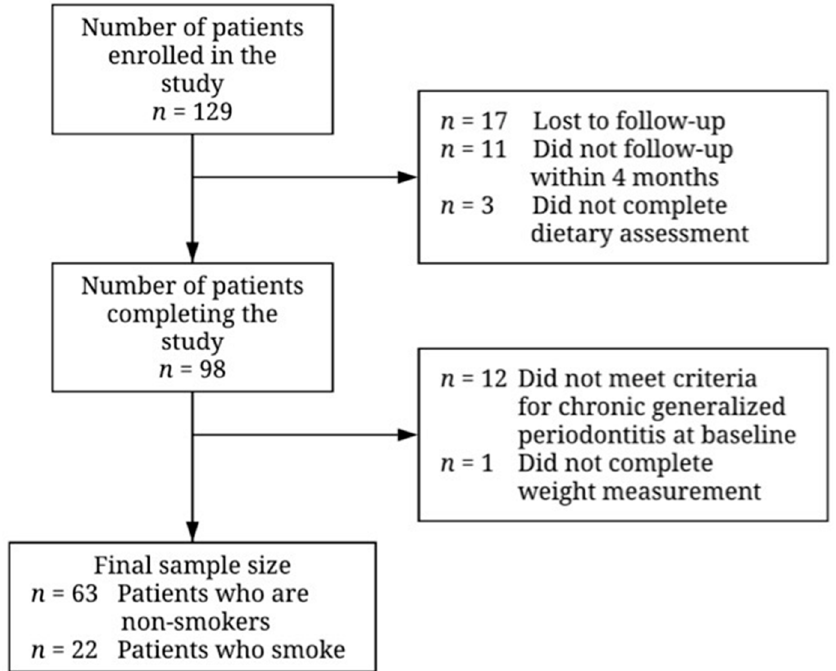
Figure 1. Flowchart illustrating recruitment and final sample size for patients undergoing non- surgical periodontal therapy. Reasons for exclusion of participants are given to the right of the arrows denoting the transitions between